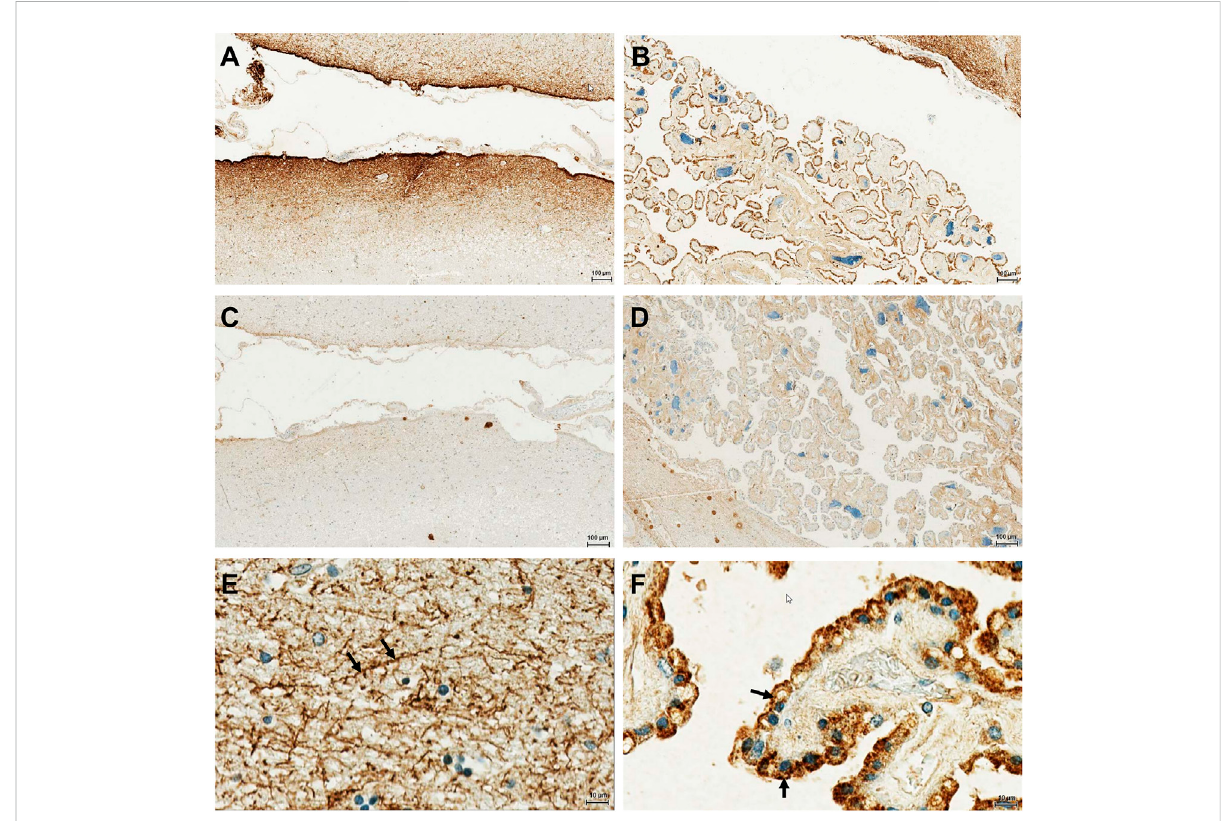
FIGURE 4 Immunohistochemical localization of OATP3A1_V3 in the human brain. The paraf fi n-embedded brain section was stained with the anti- OATP3A1_V3 antibody. (A) . Strong positive immunoreactivity was detected in the outer (subpial) cortex (A) and in the choroid plexus (B) . (C,D) Absence of stainingafter preincubationoftheantibodywith thepeptide used for immunization(negative control). (E) Positivestaining wasobserved in the brain cortex associated with neuronal axons (arrow). (F) Choroid plexus epithelium stained with the anti-OATP3A1_v3 antibody showing positive immunoreactivity at the apical (ventricular lumen facing) membrane (arrow). Nuclei were counterstained with hematoxylin.